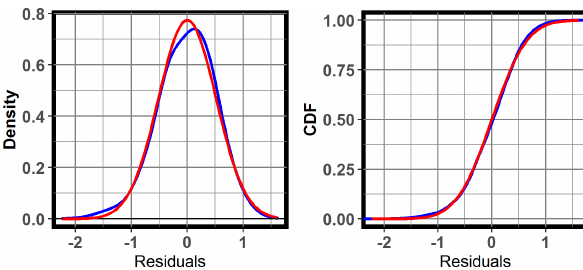
Figure 11: Goodness of fit of the residual distribution of the Holt- Winters model to the normal distribution